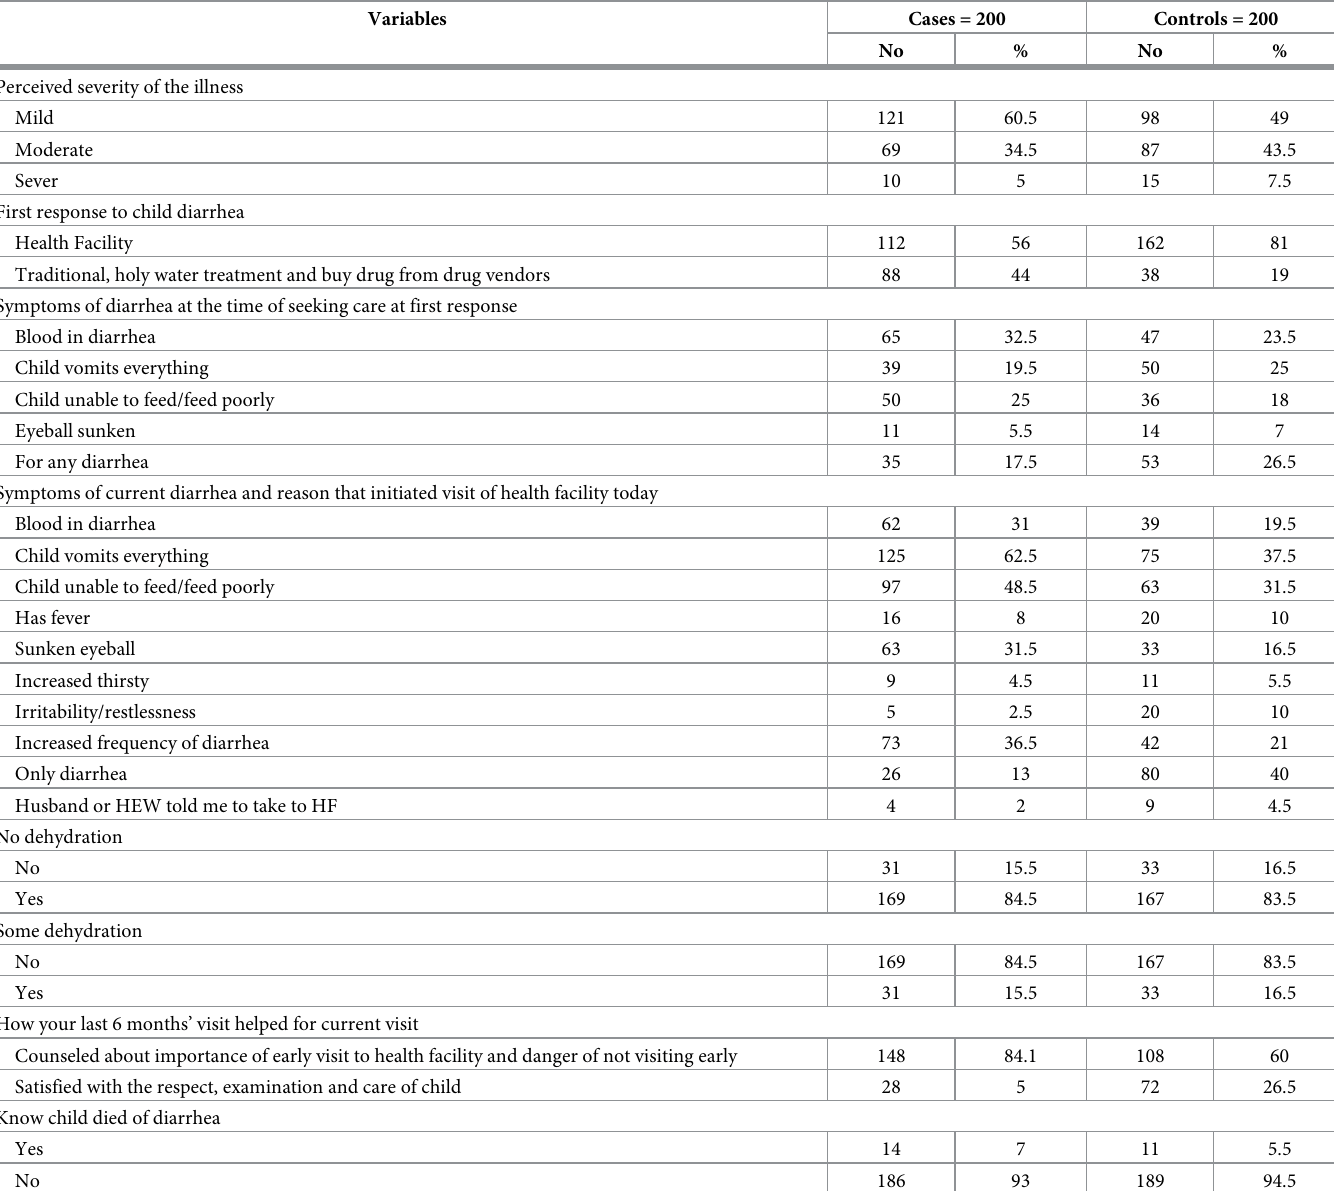
Table 3. Need/Disease related factors affecting delay in care seeking of mothers’/caregivers’ of < 5 children with diarrheal diseases in public health facilities of Arba Minch town, south Ethiopia, 2019(n =